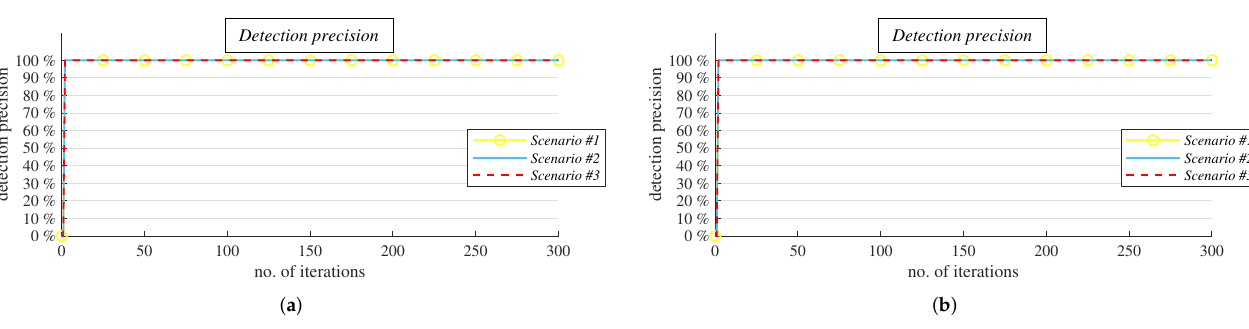
Figure 16. Evaluation of detection precision of proposed mechanism in random graphs with various connectivity under three scenarios. ( a ) Random graphs with p = 5%. ( b ) Random graphs with p = 10%. ( c ) Random graphs with p = 20%. ( d ) Random graphs with p = 30%.